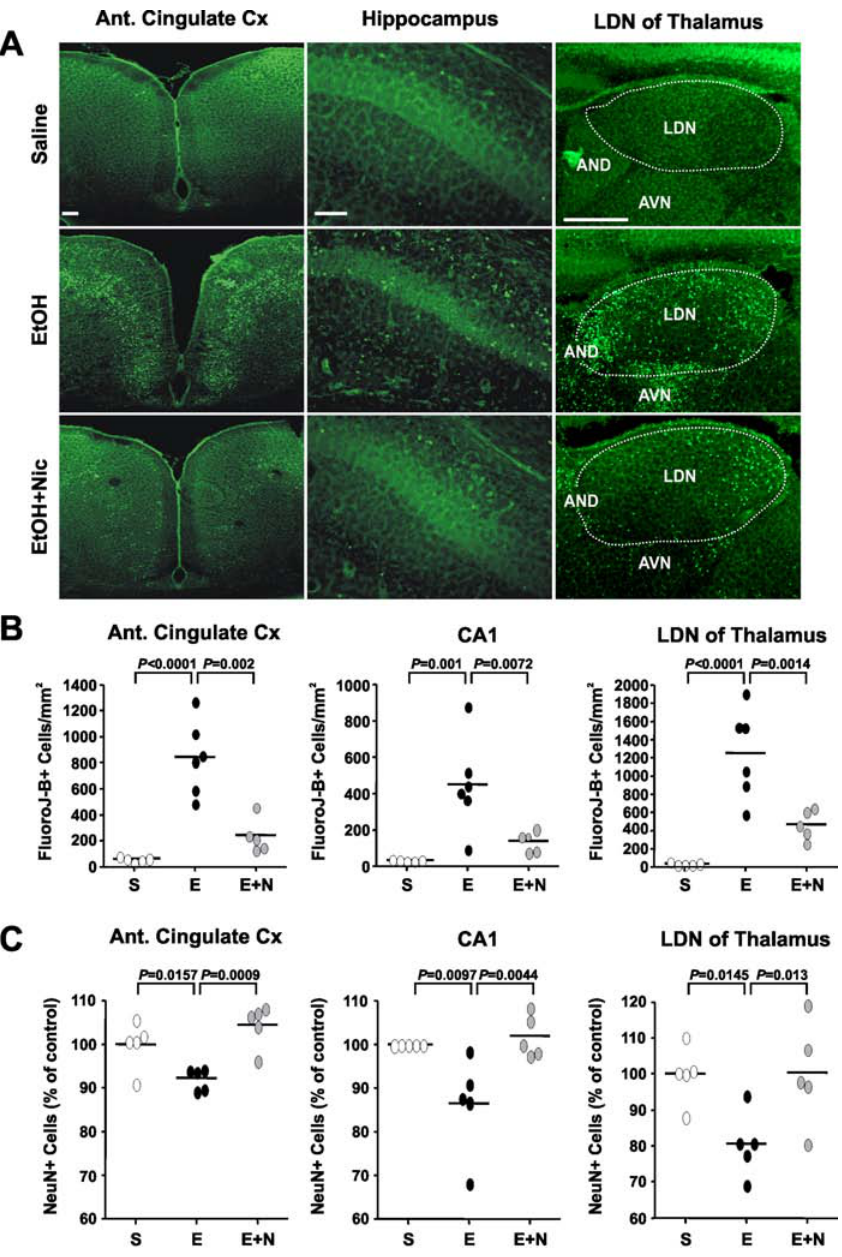
Figure 3. Nicotinamide Inhibits Ethanol-Induced Neurodegeneration (A) Fluoro-Jade B staining 24 h after ethanol treatments. (B) Quantification of Fluoro-Jade–B positive cells in the cingulate cortex (ANOVA F 2,13 ¼ 25.541; p , 0.0001; n ¼ 5–6 each treatment group), in the total CA1 region of hippocampus (ANOVA F 2,13 ¼ 9.988; p ¼ 0.0024; n ¼ 5–6 each treatment group), and in the LDN of thalamus (ANOVA F 2,13 ¼ 20.785; p , 0.0001; n ¼ 5–6 each treatment group). (C) Total number of NeuN positive cells were counted 2 wk after ethanol administration in the cingulate cortex (ANOVA F 2,12 ¼ 9.894; p ¼ 0.0029; n ¼ 5 each treatment group), in the CA1 region of hippocampus (ANOVA F 2,12 ¼ 7.289; p ¼ 0.0085; n ¼ 5 each treatment group) and in the LDN of thalamus (ANOVA F 2,12 ¼ 5.551; p ¼ 0.0196; n ¼ 5 each treatment group). Values are shown as mean 6 SD. Bonferroni correction for multiple comparison revealed a significant difference between ethanol treatment group and all other